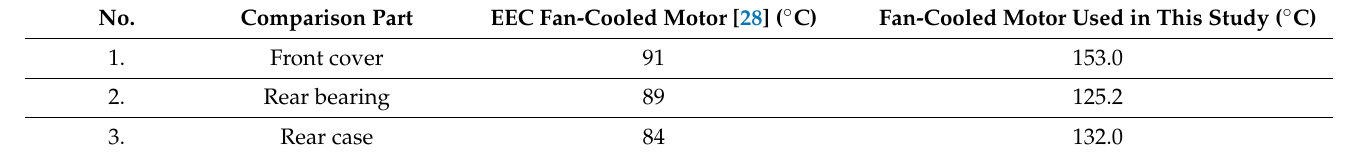
Table 7. Comparison of thermal analyses of two fan-cooled motors from a previous study 28 and this study.